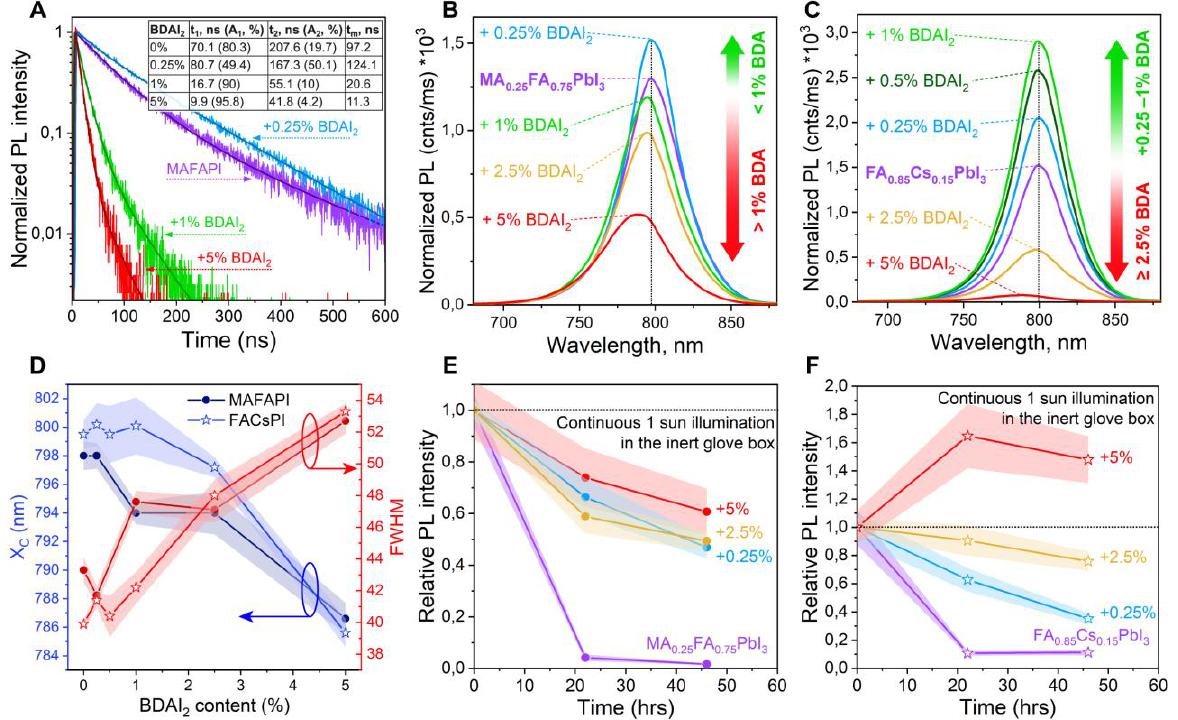
Figure 4. ( A ) Time-resolved PL decay curves of MA 0 . 25 FA 0 . 75 PbI 3 + x% BDAI 2 films. Estimated charge carrier lifetimes (t 1 and t 2 with corresponding relative amplitudes A 1 and A 2 , and average lifetime t m ) are given in the inset table in ( A ). ( B , C ) Steady-state PL spectra of MA 0 . 25 FA 0 . 75 PbI 3 + x% BDAI 2 ( B ) and FA 0 . 85 Cs 0 . 15 PbI 3 + x% BDAI 2 ( C ) films. ( D ) Graphical illustration of PL peak positions (X C ) and widths (FWHM) as a function of BDAI 2 content for both MAFAPI ( –●– ) and FACsPI ( – ✩ – ) samples. ( E , F ) Photostability of MAFAPI ( E ) and FACsPI ( F ) films with different BDAI 2 contents as an evolution of PL intensity, under continuous 1 sun irradiation in inert glove box.